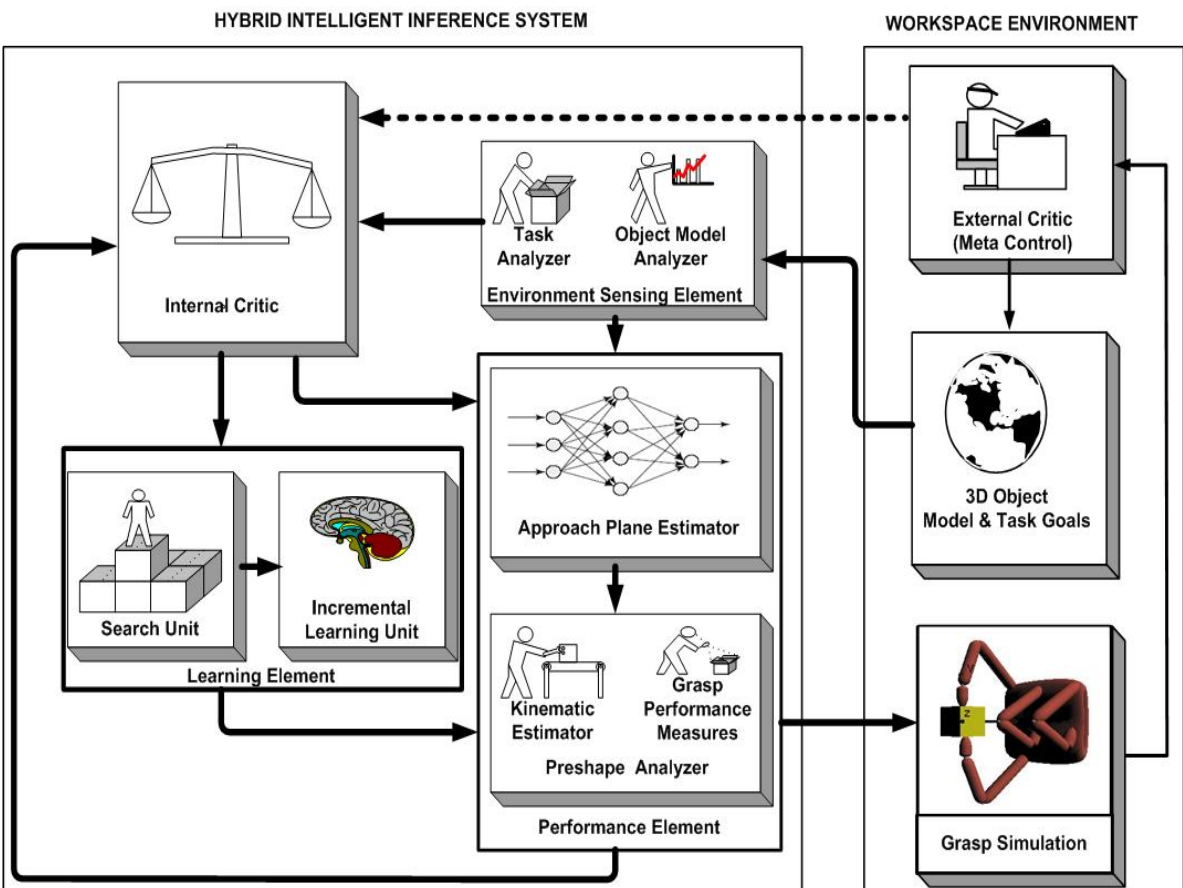
Figure 9. Overview of the Hybrid Inteligent Inference System